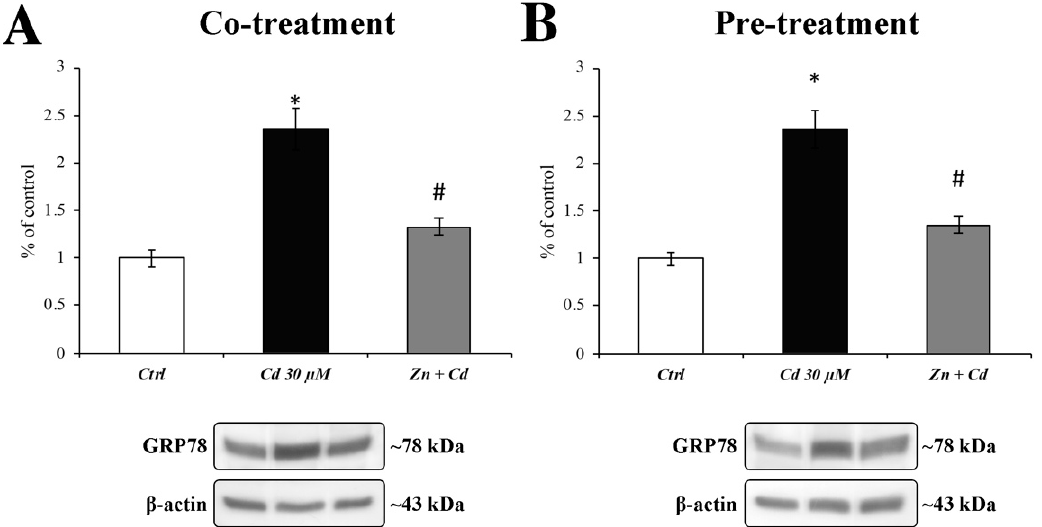
Figure 5. GRP78 protein expression after CdCl 2 and ZnCl 2 exposure. Histograms represent the quantitative analysis of the GRP78 protein expression levels evaluated by Western blotting. A sig- nificant increase in GRP78 levels (indicative of ER stress) during CdCl 2 30 µM treatment (black col- umns) was revealed. This protein increment was prevented by ZnCl 2 50 µM (grey columns), both in cotreatment ( A ) and 24 h pretreatment ( B ) regimens. Results are expressed as mean ± SEM and control (untreated cells) was arbitrarily taken as 100%. The β -actin housekeeping protein was used as an internal control for protein normalisation. Each experiment point was performed in triplicate, from three different sets of experiments. * p < 0.05 vs. Ctrl; # p < 0.05 vs. Cd treatment.